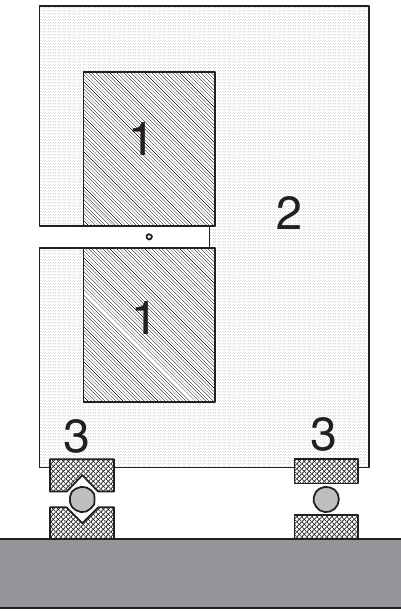
FIG. 13. Side view of a half period of the fixed-gap VPU. (1) Poles, (2) plate, and (3) ball-bearing